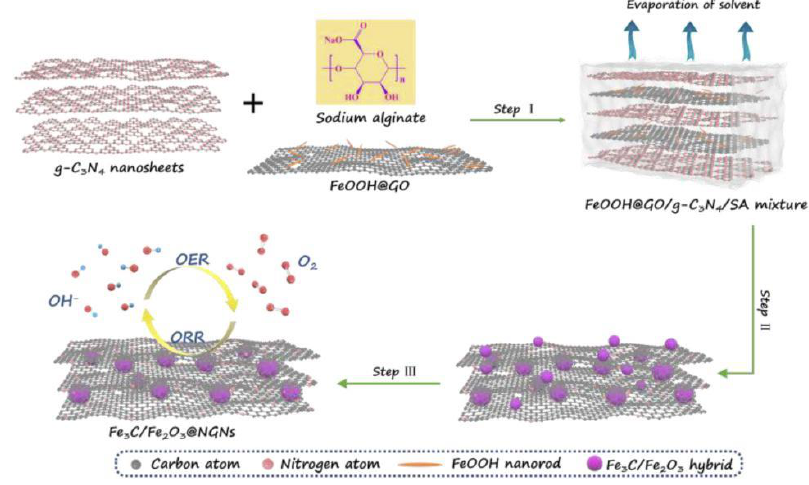
Figure14. SynthesismethodforFe 3 C / Fe 2 O 3 @NGNs. Reproducedwithpermissionfrom[43]. Copyright Figure 6. Synthesis method for Fe 3 C/Fe 2 O 3 @NGNs. Reproduced with permission from [43]. Copyright 2019 Carbon 2019 Carbon .